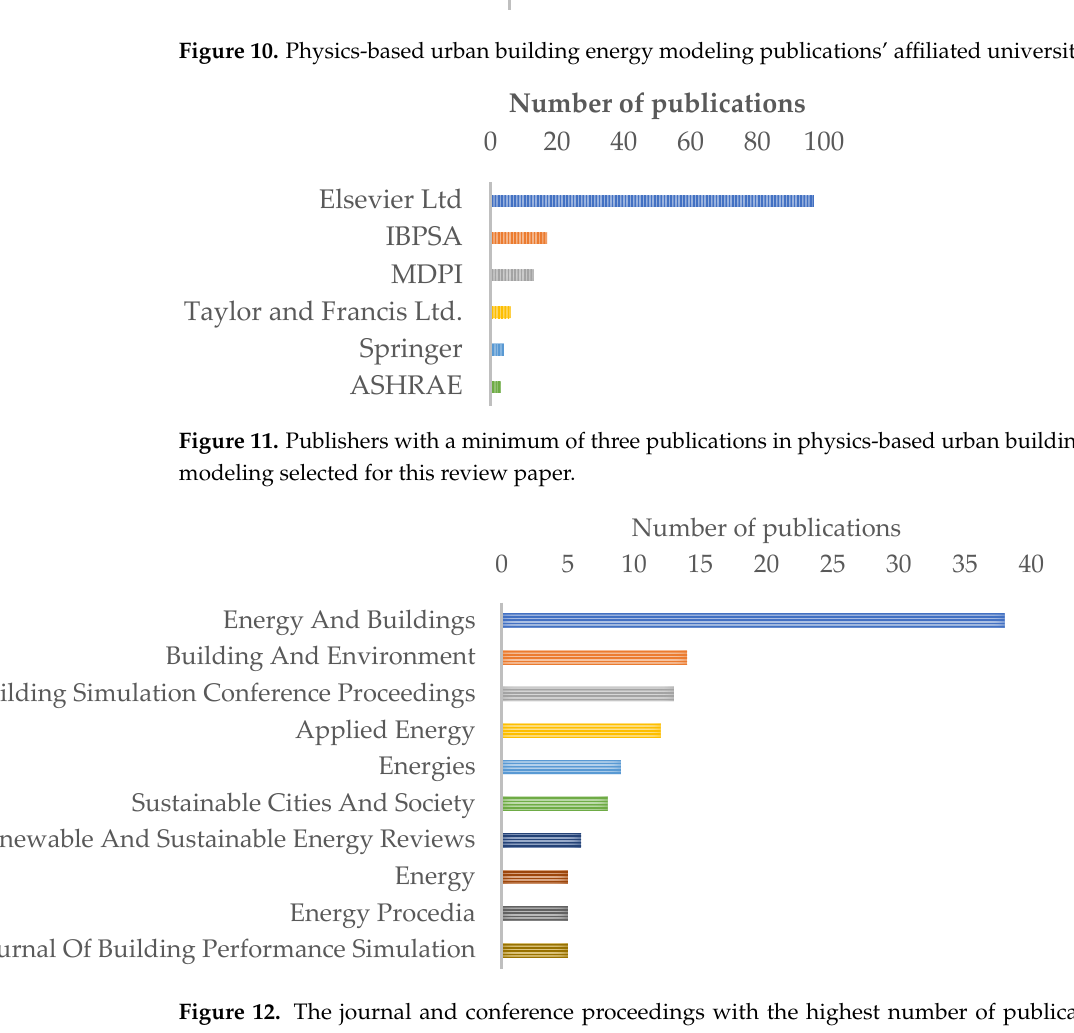
UBEM requires a large amount of data to model many buildings properly. One of the most common and convenient input data sources in UBEM development is using proto- type building data instead of measured data. BEM computer model inputs could be cate- gorized into five types: (1) geometry and location, (2) HVAC and hot water systems, (3) building envelope systems, (4) schedules, and (5) weather data. Figure 13 shows that the geometrical data are the most accessible measured data in UBEM studies. This is followed by envelope, schedules, WWR, and HVAC systems. This indicates the lack of tools, meth- ods, and open data on specific building systems and energy modeling inputs, including the HVAC and hot water system, WWR, schedules, and building envelope thermal prop- erties for large-scale energy modeling (i.e., UBEM). The following five sub-chapters cover these categories in more detail. Figure 13. Number of studies using specific measured or surveyed building systems and energy modeling inputs. 3.2.1. Geometry and Location The geometrical and location data is the most common measured input in UBEMs. Researchers use several methods or sources to obtain these open-source data through